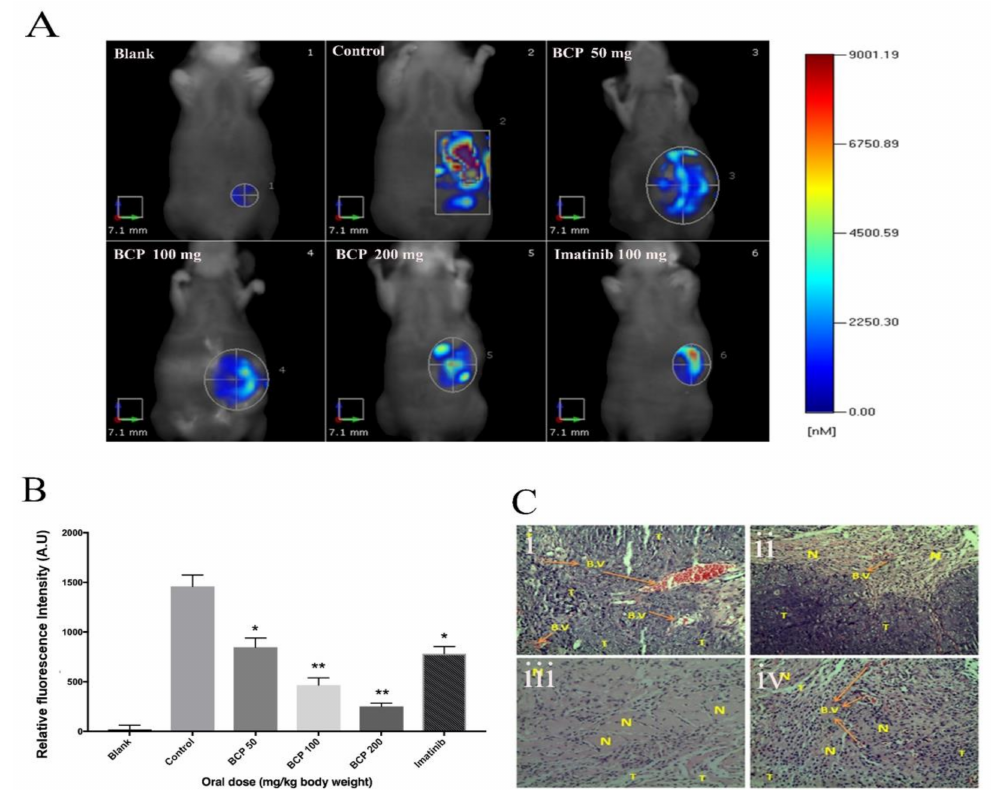
Figure 6. BCP inhibited tumor growth in an orthotopic tumor model as detected by Fluorescent Molecular Tomography. Photographic images represent the anti-tumor activity of BCP. HCT 116 tumor cells implanted orthotopically in the cecal wall of the nude mouse; ( A ) (1) Blank: normal mice, (2) negative control: untreated mice bearing tumor, (3) mice treated with 50 mg/kg of BCP, (4) mice treated with 100 mg/kg of BCP, (5) mice treated with 200 mg/kg of BCP and (6) positive control: mice treated with 100 mg/kg of Imatinib. ( B ) Graphical representation of the fluorescent intensity of the tumor in mice treated without and with BCP detected by Fluorescent Molecular Tomography. All data were represented as mean ± SD, n = 5, * p < 0.05 and ** p < 0.01 compared to control. ( C ) Cross-sections of orthotopic tumor tissues stained with hematoxylin/eosin. The pictures were captured at 20 × magnification. ( i ) Negative control with more blood vessels, ( ii ) 100 mg/kg of BCP, ( iii ) 200 mg/kg of BCP, and ( iv ) positive control: 100 mg/kg of imatinib. (B.V) refers to the blood vessels, (T) refers to viable tumor cells, and (N) refers to necrotic/apoptotic tumor